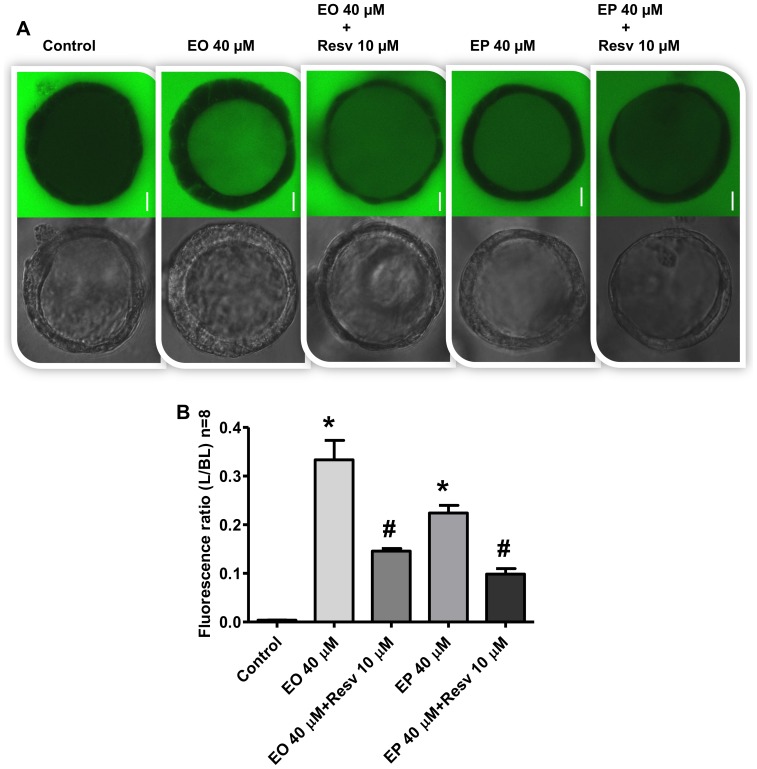
Effects of Resveratrol (Resv) on the ethyl oleate (EO)- and ethyl palmitate (EP)-induced barrier dysfunction in Caco-2 spheroids.Spheroids were exposed to medium (control) or treated with EO or EP for 24 h, or first treated with 10 µM resveratrol for 1 h prior to treatment with 40 µM of either EO or EP for 24 h. [A] Intraluminal accumulation of FITC-dextran-4 (green) was observed using confocal microscopy and representative images captured from the middle of spheroids are shown. The bar indicates 10 µm. [B] The mean fluorescence intensity of FITC-dextran-4 after exposure was measured and expressed as the ratio of the luminal (L) over the basal (BL) compartment. Values are Means±SD, *p<0.0001 vs. medium only-treated control, #
p<0.0001 vs. treated only with EO or EP. FITC-dextran-4 fluorescence ratio, EO 40 vs. EP 40 µM; (p<0.0001, Figure 6A and 6B).